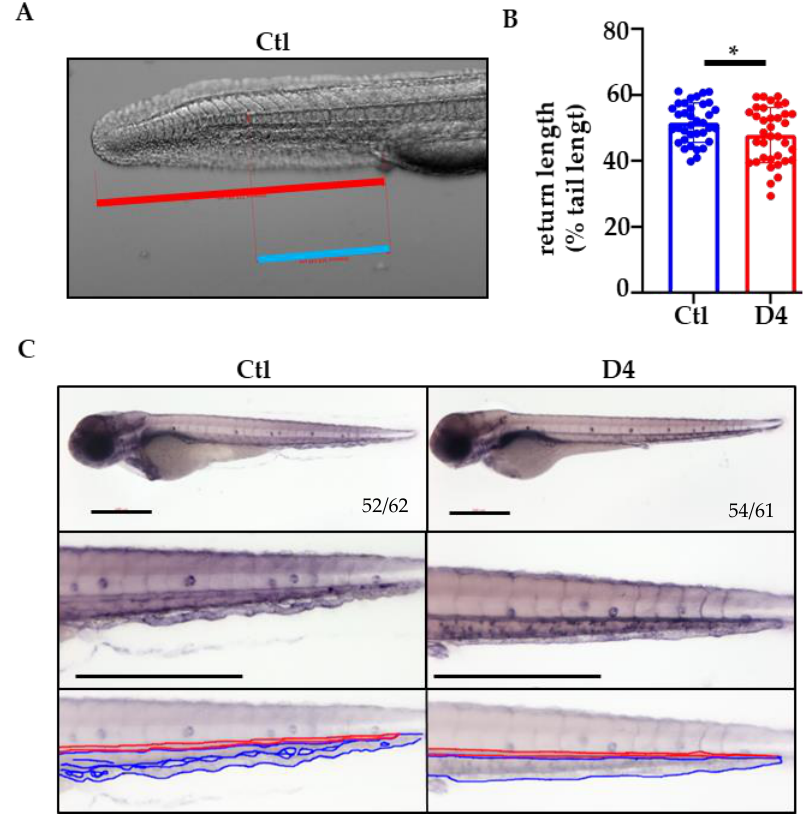
Figure 5. Effects of the absence of pank2 on vasculature development. ( A ) Measurement of the venous return in embryos at 24 hpf; the blue line indicates the length of the caudal vein, and the red line is that of the tail. The measurement was expressed as the ratio between the two values (percentage). ( B ) The graph in the panel shows the mean values obtained in control and mutant embryos (Ctl = 51.6%; D4 = 47.9%). The experiment was repeated twice on 36 embryos/group. * p < 0.05, Student’s t -test. ( C ) Representative images of the phosphatase assay for vessel visualization on 72 hpf embryos. The red line decorates the dorsal aorta; the blue one is the caudal plexus. The numbers at the bottom of the images indicate the ratio between embryos with the observed phenotype and the total number of stained embryos. The experiment was performed 3 times on at least 60 embryos/group. Size bar = 500 µm.